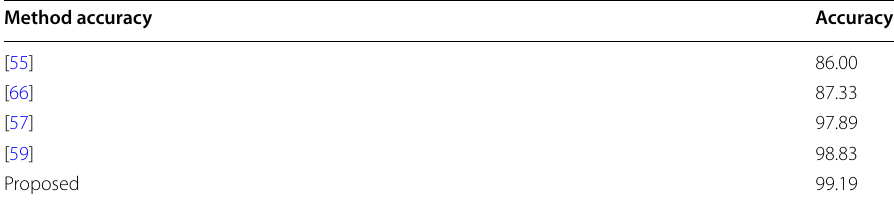
Table 6 Detection accuracy on Media Lab dataset